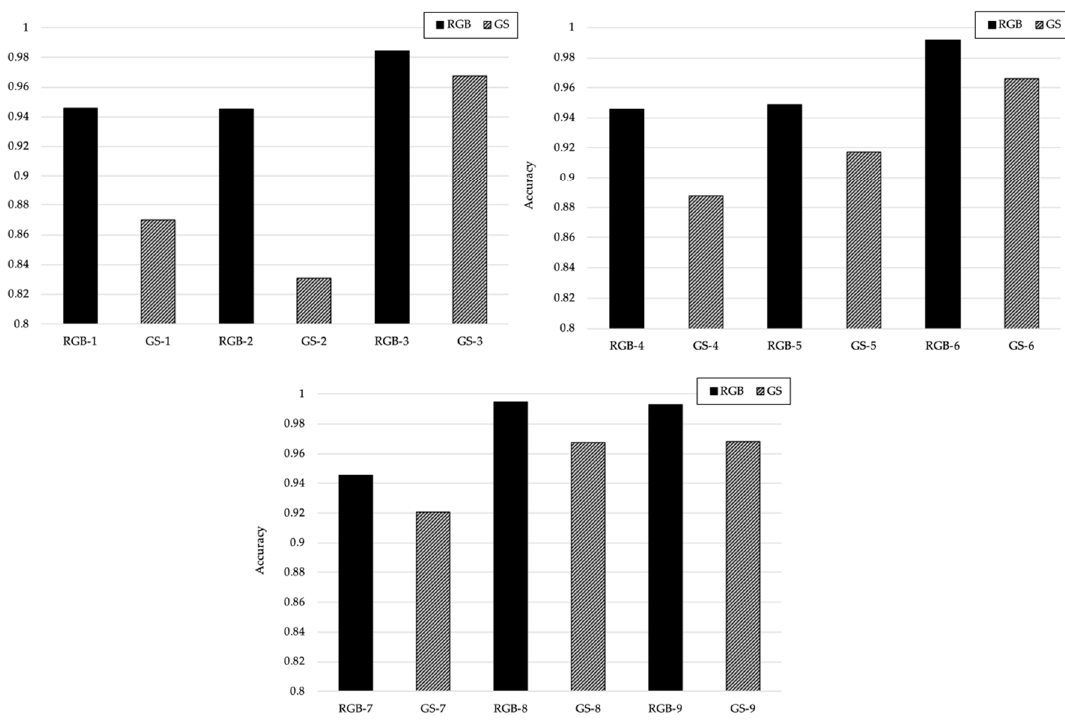
Table 9. Comparison of Accuracy by Number of Convolution Layers in multiclass classification in case of KDD.